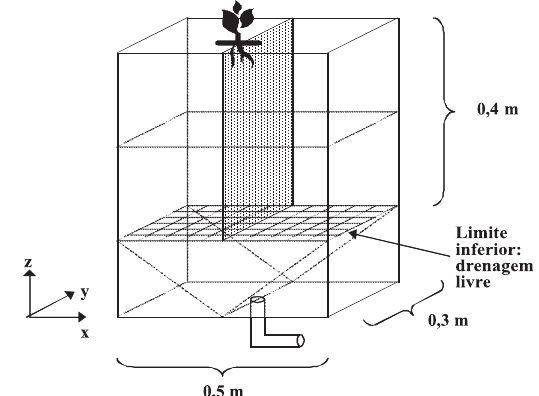
Figura 1. Desenho esquemático de um lisímetro dividido utilizado no experimento, mostrando dimensões e divisão